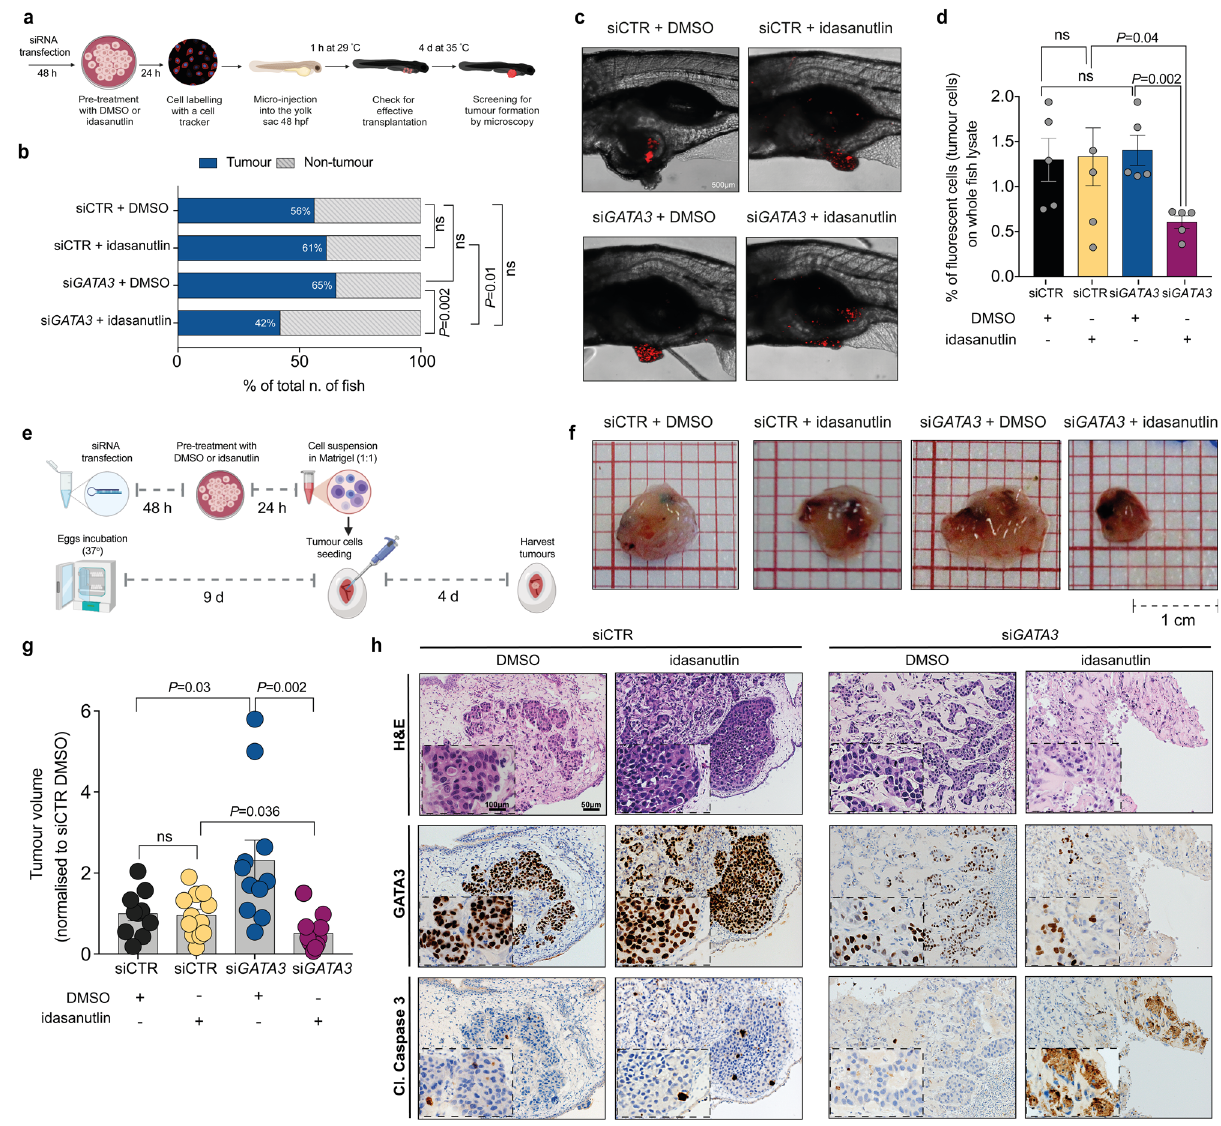
Fig. 3 GATA3 expression determines response to MDM2 inhibitor in vivo. a Schematic representation of the zebra fi sh xenotransplantation assay. b Barplot shows the percentages of fi sh that harbored or did not harbor tumors upon transplantation with GATA3 -silenced or control BT-474 cells pre- treated with idasanutlin or DMSO. In total, 70 – 100 embryos per group were analyzed over two independent experiments. c Representative confocal images of tumor formation in zebra fi sh injected with fl uorescent tracker-labeled BT-474 cells with GATA3 siRNA or control siRNA, pretreated with idasanutlin or DMSO. d FACS analysis showing the percentage of red-tracker labeled tumor cells extracted from the embryos. Error bars represent, in total, three replicates performed over two independent experiments. Each replicate represents the pooled lysate of 20-30 fi sh for each condition. e Schematic illustration of the CAM assay. f Photographs of GATA3 -silenced or control BT-474 cells pre-treated with DMSO or idasanutlin implanted in CAMs and grown for 4 days post-implantation. g Volume of tumors derived from the CAM experiment ( n ≥ 10 tumors over three independent experiments). Values are normalized to the mean of siCTR DMSO. h Representative micrographs of BT-474 tumors extracted 4 days post-implantation. Tumoural cells (upper) were immunostained with GATA3 (middle) and the apoptotic marker cleaved caspase 3 (lower) in the different treatment conditions (see also Supplementary Fig. 3). Data are mean ± SEM n ≥ 4 biologically independent experiments. Scale bars: c 500 μ m, f 1 cm and h 50 and 100 μ m. Statistical signi fi cance was determined for b by two-sided Fisher ’ s Exact test and for d , g by two-tailed unpaired Student ’ s t test. a , e were created with